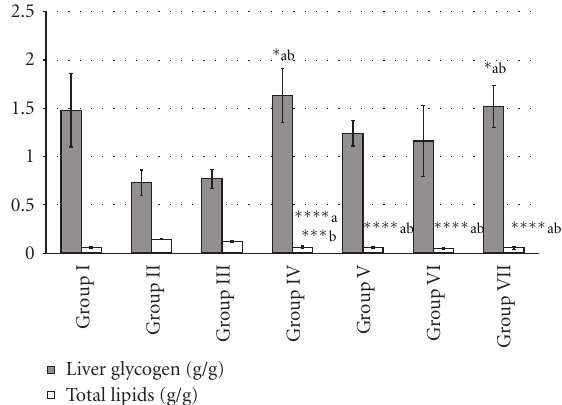
Figure 4: E ff ect of MREt on serum insulin level and insulin/glucose ratio. Each bar represents the mean ± SEM ( n = 6) . ∗ P < 0 . 05, ∗∗ P < 0 . 01, and ∗∗∗∗ P < 0 . 0001, when compared with group II (a) and III